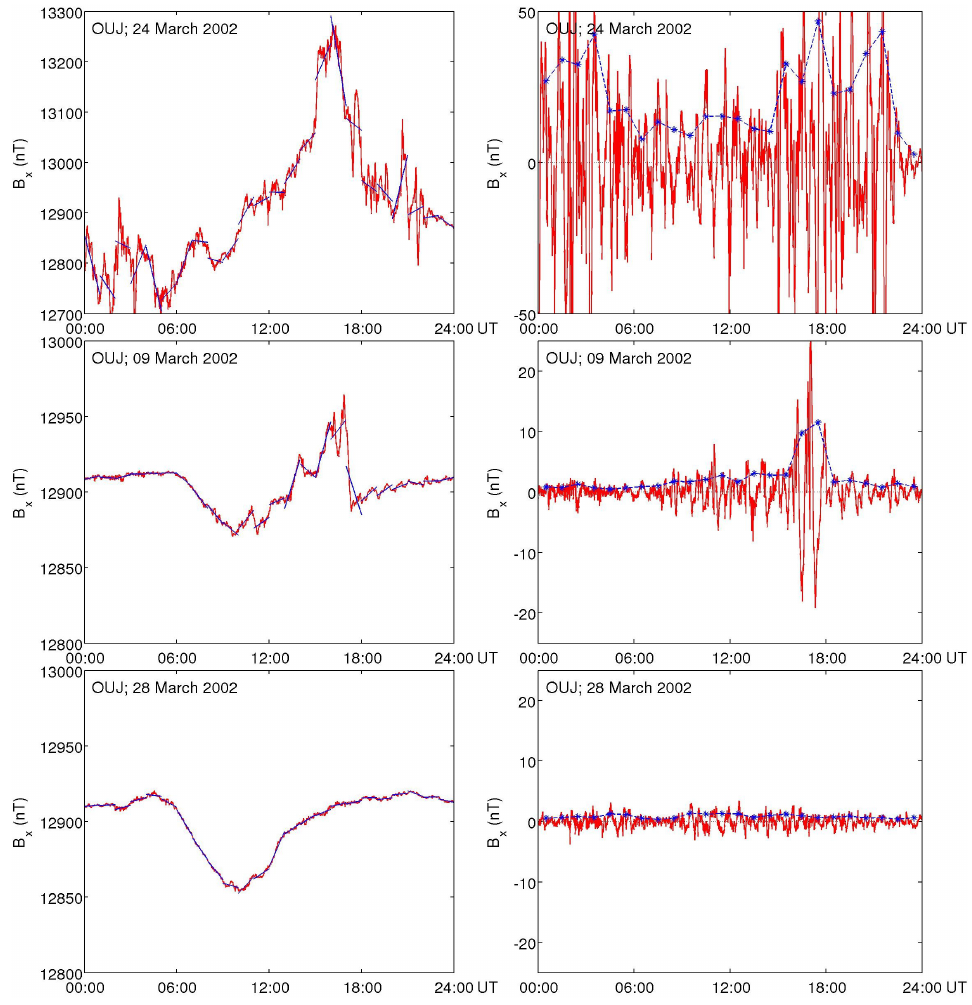
Fig. 3. The quiet-day selection procedure, demonstrated by the B x field in Oulujärvi in March 2002. Left-hand panels: raw data and the hourly lines fitted to it. Right-hand panels: the data after subtraction of the fitted lines, and the calculated hourly standard deviations. Top panels: on a disturbed day; centre panels: on a mostly quiet day with some disturbance; bottom panels: on a quiet day. The maximum σ H values (from B x alone) are 46.7 11.5, and 1.4nT, respectively.